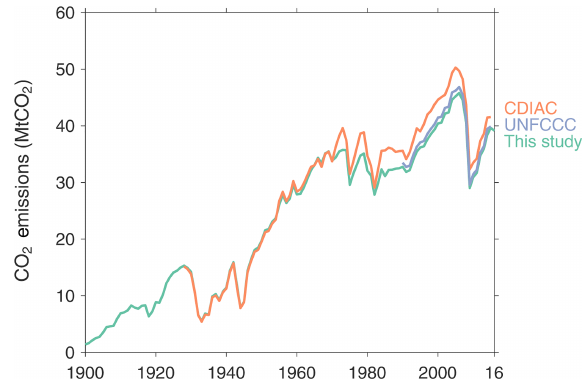
Figure D10. Revised cement emissions for the